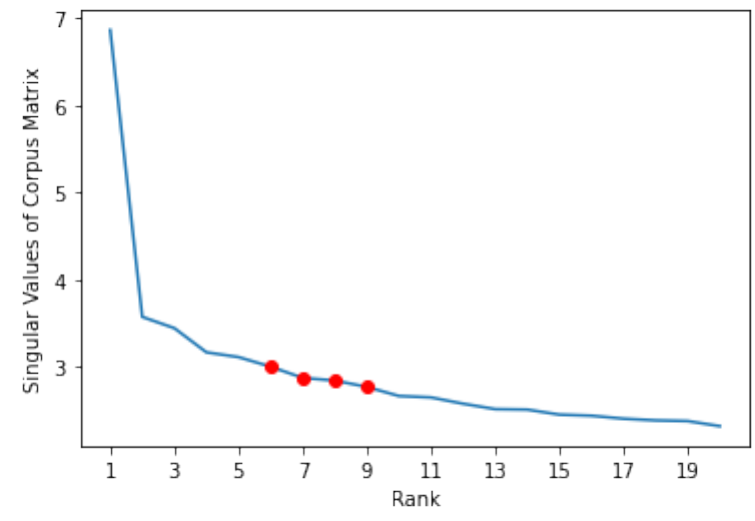
Figure 5. First 20 singular values of the 20 Newsgroups corpus